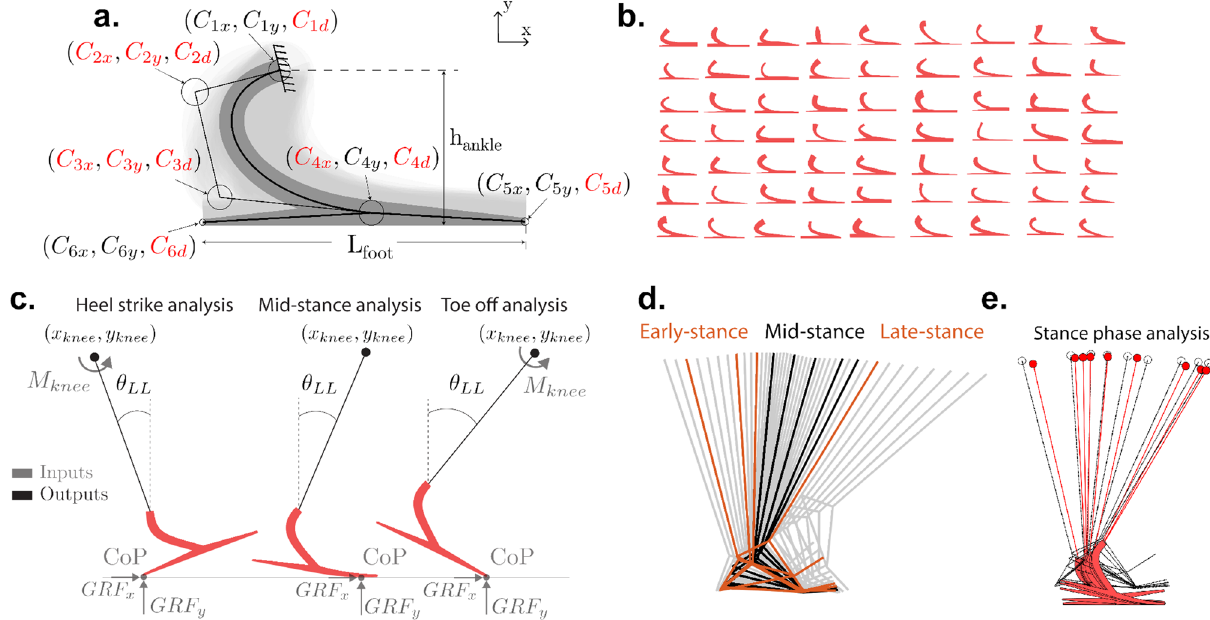
Figure 1. Overview of the LLTE design framework applied in the sagittal plane. ( a ) The prosthetic foot parametric model, shown here overlaid on the foot design space, is defined using the wide Bézier curves’ variables C ij , build height h ankle , and foot length L foot . The design space shown in light grey was created by varying each one of the 11 independent design variables shown in red. ( b ) Sampled prosthetic foot shapes from the design space. ( c ) Prosthetic foot model structural analysis process used to compute the lower leg position and orientation ( x knee , y knee and θ shank ) under a given loading condition (horizontal and vertical ground reaction forces ( GRF x and GRF y ), center of pressure (CoP), and knee moment ( M knee )). The solid line shows the shank segment connecting the prosthetic foot to the knee joint center. ( d ) Reference gait’s lower leg stance phase trajectory divided into the three main portions of stance (early, mid and late stance), with the selected frames used in the LLTE calculation shown in bold. ( e ) Resulting LLTE-predicted trajectory of the lower leg for a LLTE- optimized prosthetic foot (red) overlaid on the reference trajectory